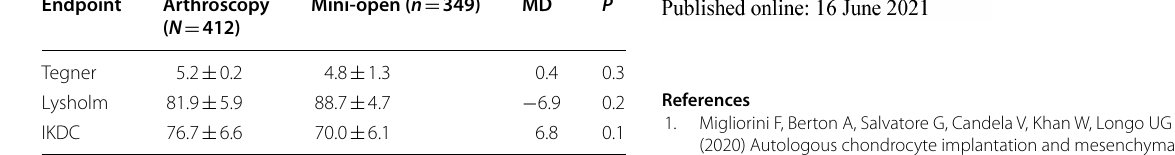
Table 5 Results of the complications